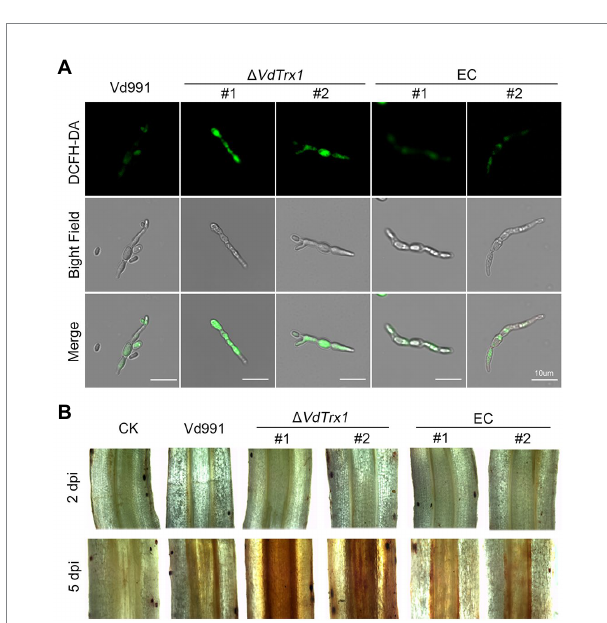
FIGURE 5 The role of VdTrx1 from V. dahliae in the degradation of ROS. (A) Hyphae from wild-type strain Vd991, VdTrx1 deletion strains, and the complemented strains were grown in liquid complete medium for 4 days. The fluorescent dye 2 ′ ,7 ′ –dichlorofluorescin diacetate (DCFH-DA) was used to visualize the production of H 2 O 2 . Bar, 10 μ m. (B) Accumulation of H 2 O 2 in infected cotton roots. Detection of H 2 O 2 accumulation in cotton roots inoculated with sterile water, the wild- type strain Vd991, Δ VdTrx1 and complemented strains at 2 days and 5 days post-inoculation, respectively, by 3,3 ′ - diaminobenzidine